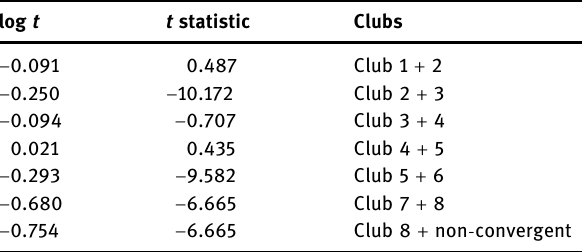
Table 4: Testing for club merging ( 1984 – 2017